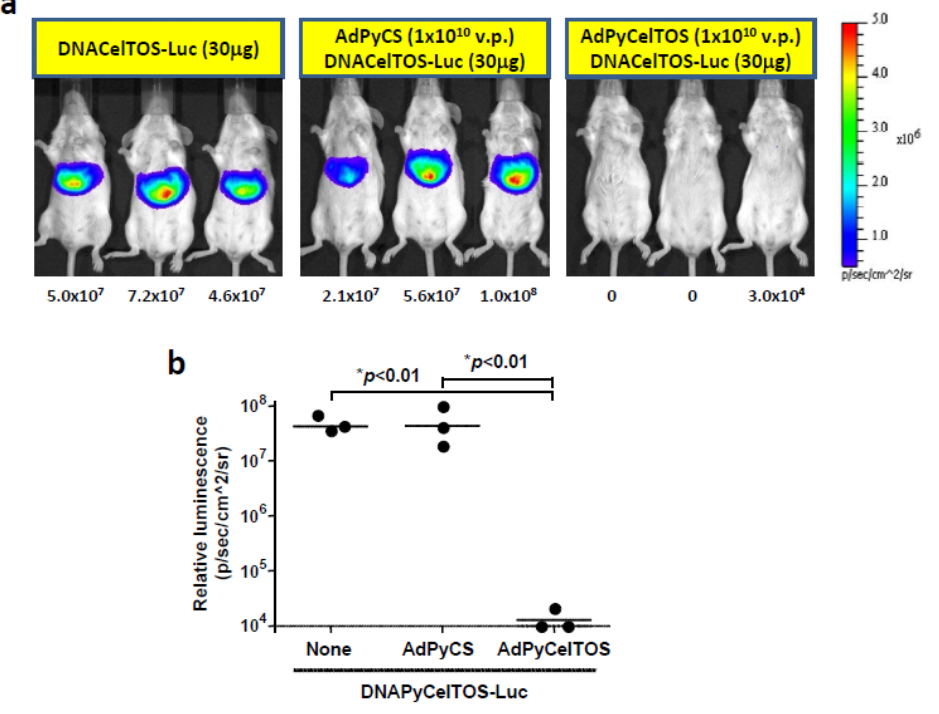
Figure 4. Luciferase expression in AdPyCS-immunized mice, AdPyCelTOS-immunized mice, or naïve mice, upon HTV injection of DNAPyCelTOS-Luc. ( a ) Noninvasive bioluminescence image shows the inhibition of DNAPyCelTOS-Luc induced luciferase expression in mice by a prior single immunizing dose of AdPyCelTOS, but not of AdPyCS. Three days after the HTV injection with DNAPyCelTOS-Luc, mice were anesthetized and injected with D-luciferin, and the luciferase intensity was optically imaged; ( b ) Quantification of the bioluminescent signal intensity in AdPyCS-immunized mice, AdPyCelTOS-immunized mice, or naïve mice, upon HTV injection of